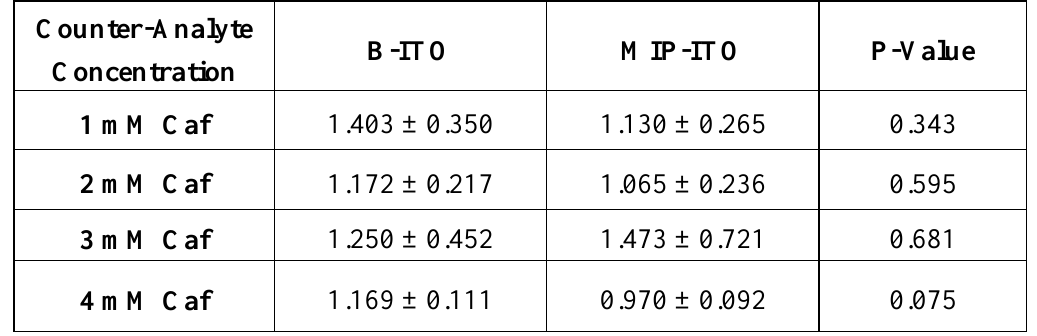
Table 1. Ratio of Maximum Currents of B-ITO and MIP-ITO Sensor at Various Counter